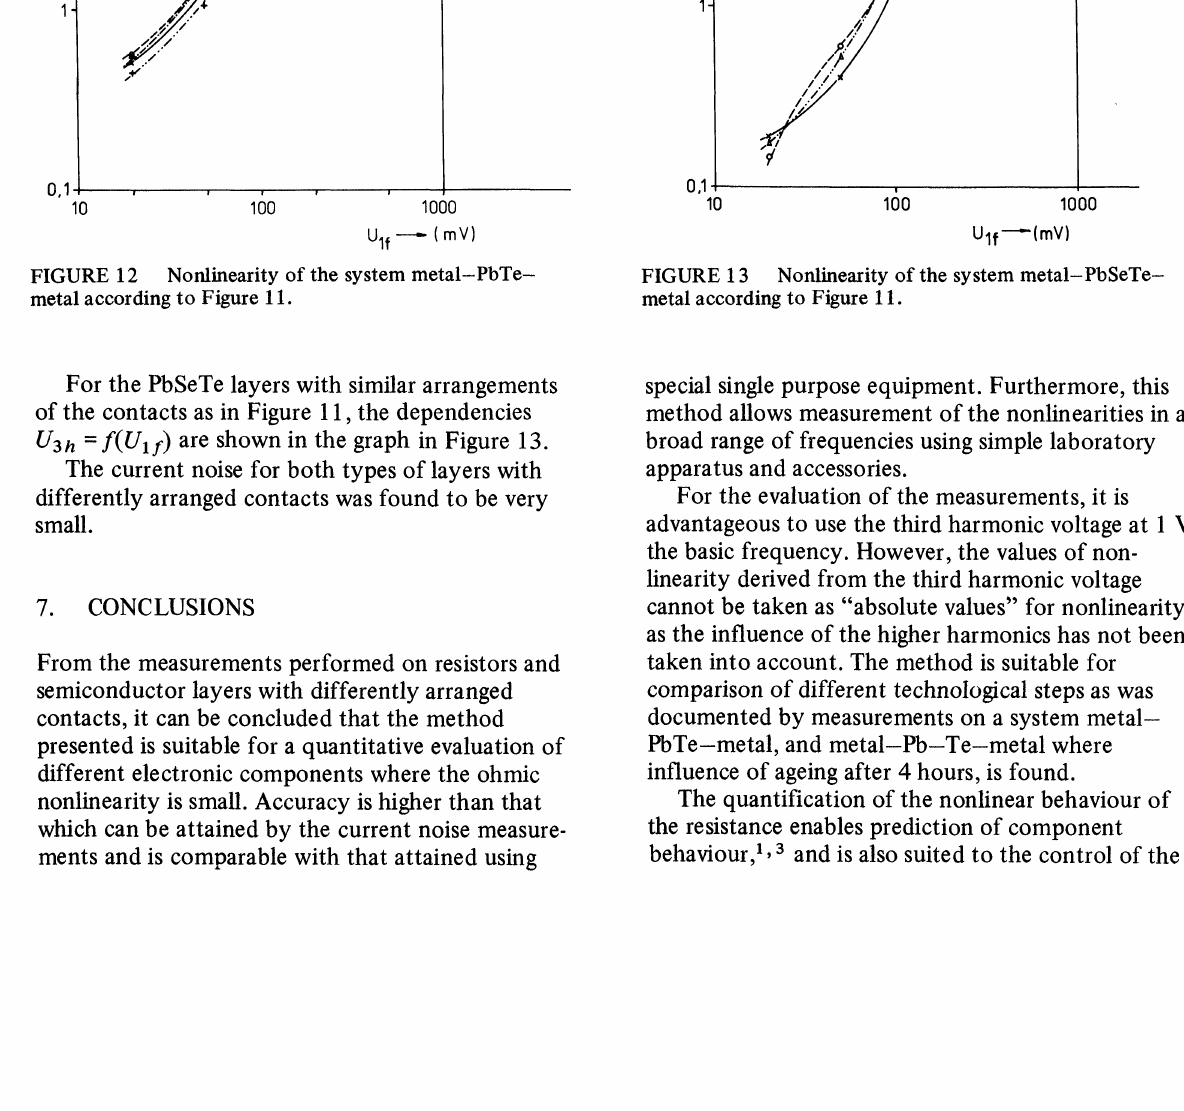
Nonlinearity of the system metal-PbTe- metal according to Figure 11.